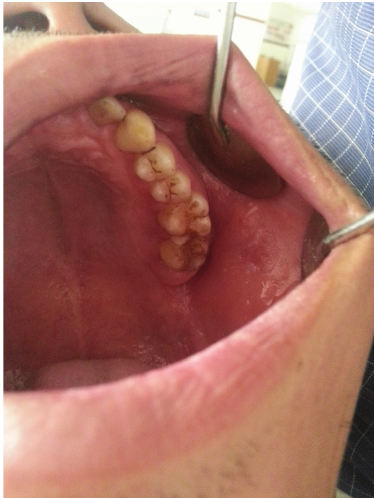
Figure 7: One month post operative view (maxillary).